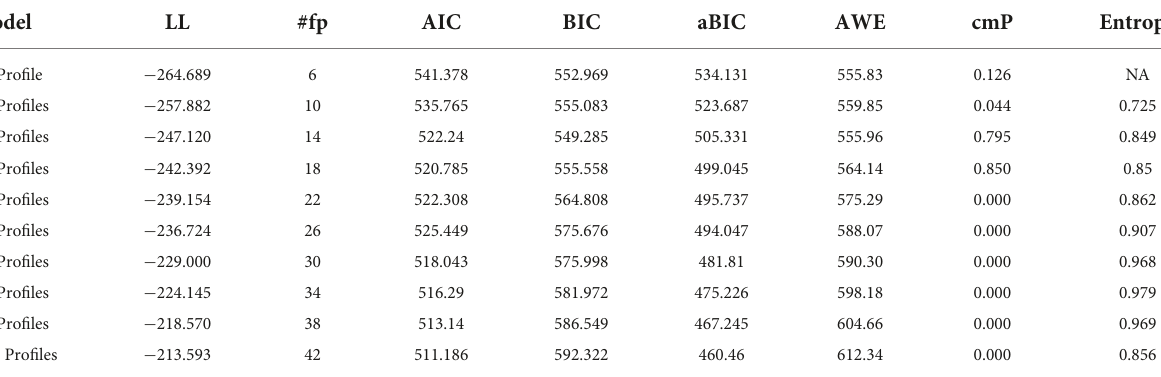
TABLE 4 Statistical results from the latent profile analysis ( t 2 ).